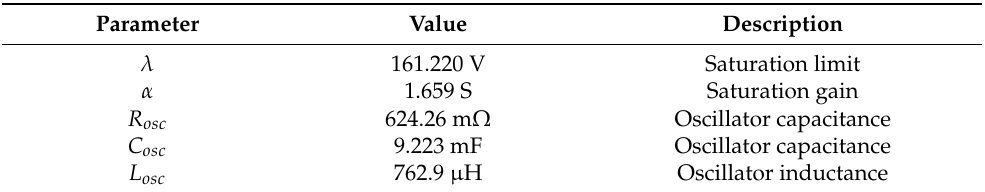
Table 2. Output parameters Proposed Method (PM).